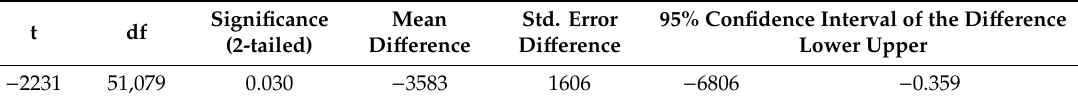
Table 2. Di ff erence in modified Coleman methodology score (MCMS) between articles written before 2010 and articles written after 2010 (using Independent Samples t -test).